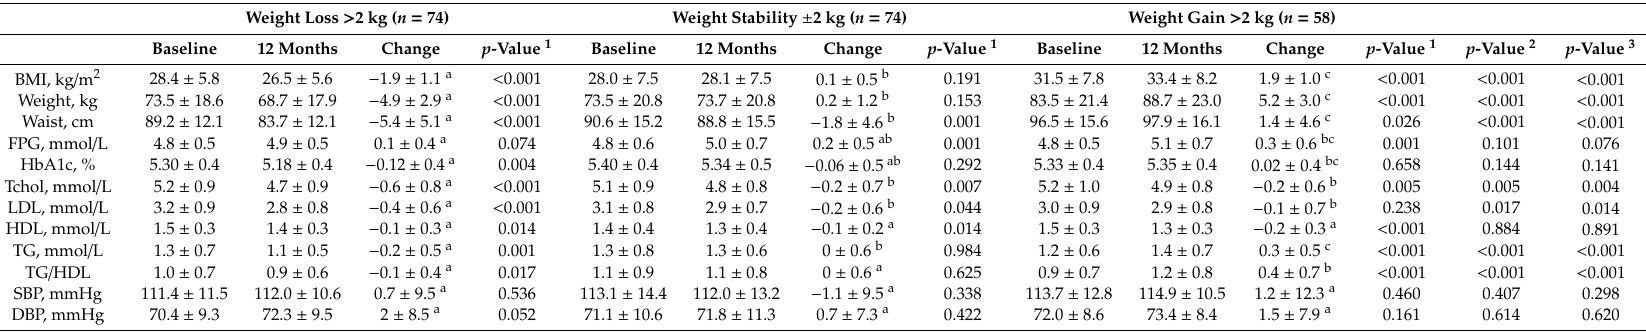
Table 2. Anthropometric and cardiometabolic outcomes by weight change at 1-year during the Mothers After Gestational Diabetes in Australia